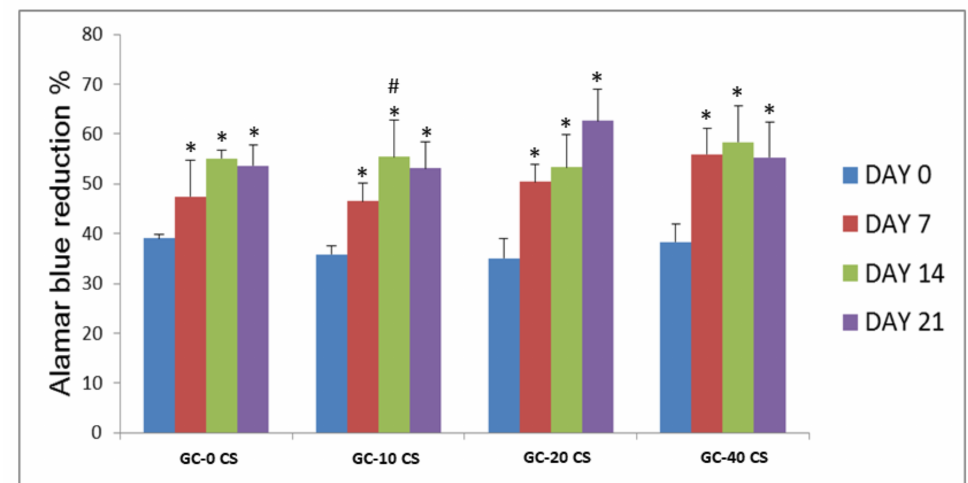
Figure 5. Proliferation and viability (% of Alamar Blue reduction) of hBMSCs seeded in GC-0 CS, GC-10 CS, GC-20 CS, and GC-40 CS scaffolds at days 0, 7, 14, and 21. Statistical analyses: One-way ANOVA followed by Post-Hoc LSD test; * p < 0.05 indicates the level of statistical significance between days 7, 14, and 21 against day 0; # p < 0.05 indicates comparison between days 7 and